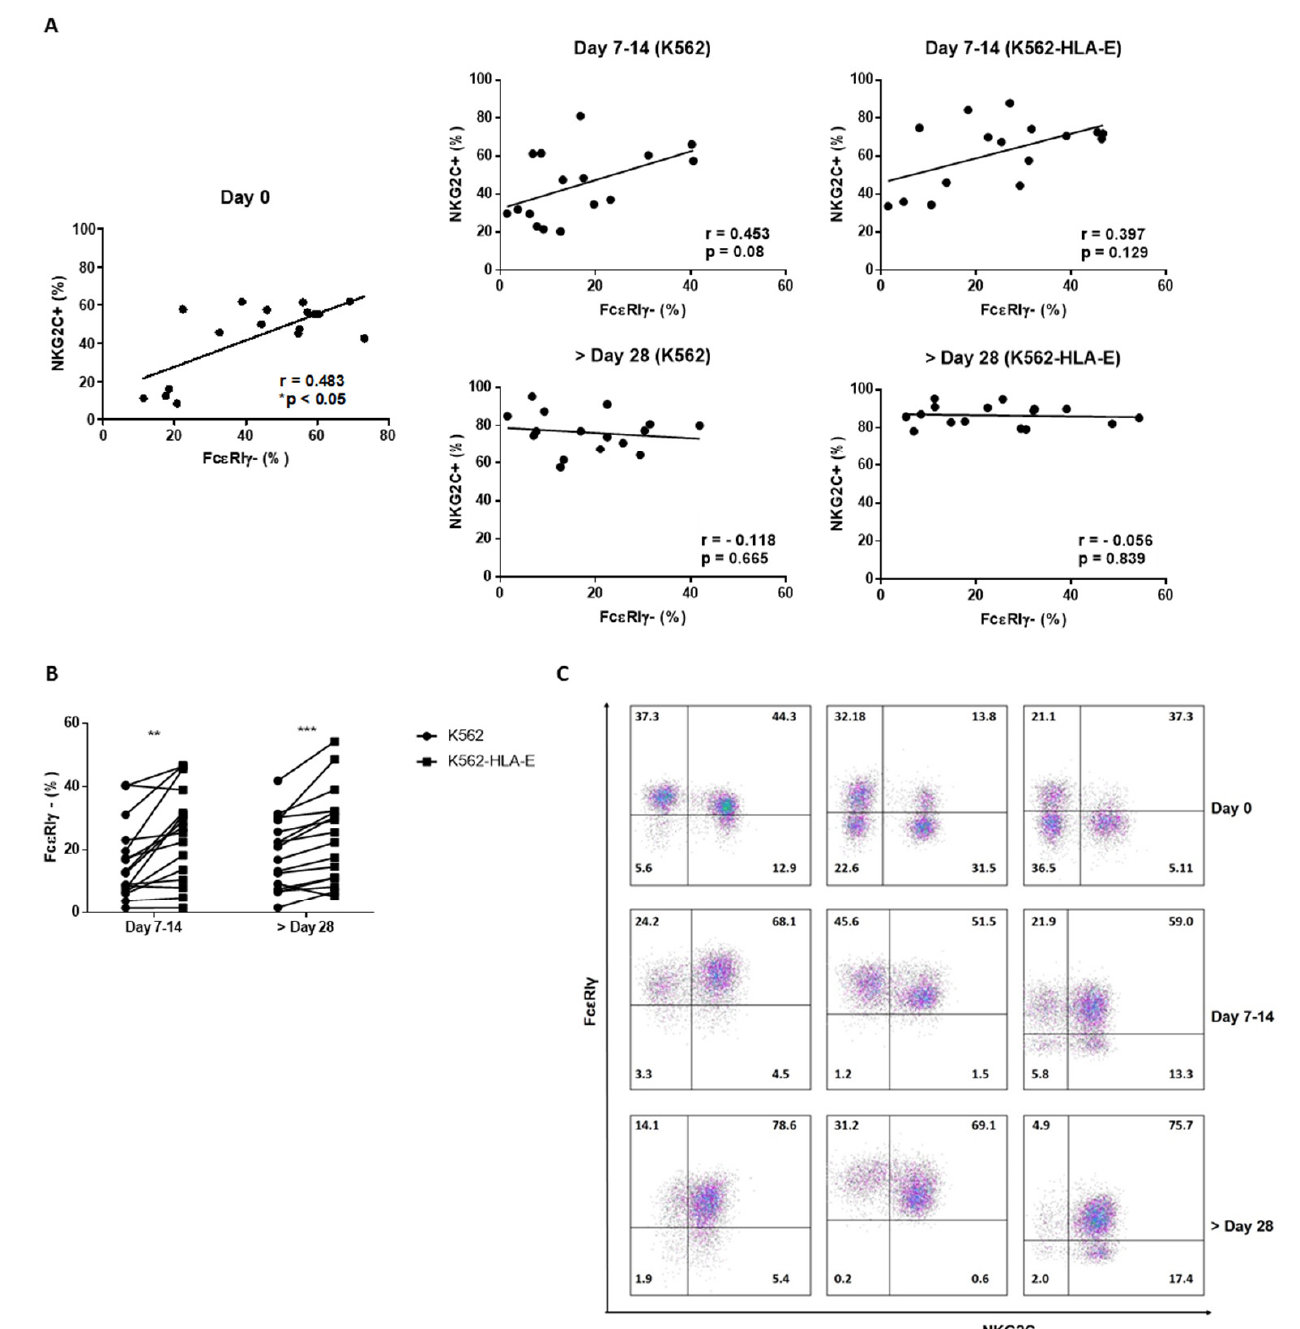
Figure 5. The frequency of FcεRIγ and NKG2C in natural killer (NK) cells during expansion. ( A ) Correlation of the frequency of FcεRIγ- NK cells and NKG2C+ NK cells before and following NK cell expansion ( n = 16 donors). ( B ) Comparison of proportions of FcεRIγ- expression between NK cells expanded with K562 and K562-HLA-E cells. ( C ) Representative flow cytometry plots of FcεRIγ and NKG2C of three donors during NK cell expansion with K562-HLA-E cells. All data are shown as mean ± SEM ( n = 16 independent experiments; ** p < 0.01; *** p < 0.001).